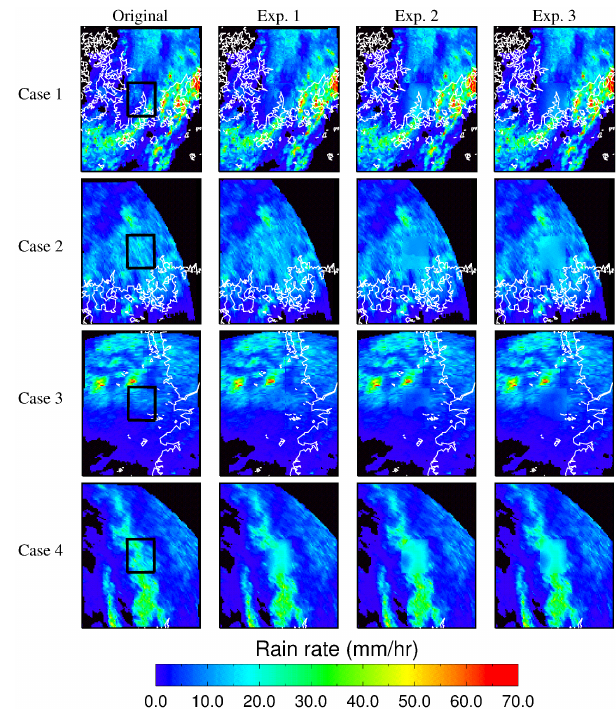
Figure 7. Precipitation distributions estimated by the Jindo radar for the four precipitation cases (the first column), same as in Fig. 6, but focused on the surrounding of the gap areas (black line box). Precipitation estimations over the black boxes from the three merg- ing experiments employing the optimal weights determined by the original radar data and the AWS data, and the equal weights (1 / 2) are illustrated in the rest of the columns,